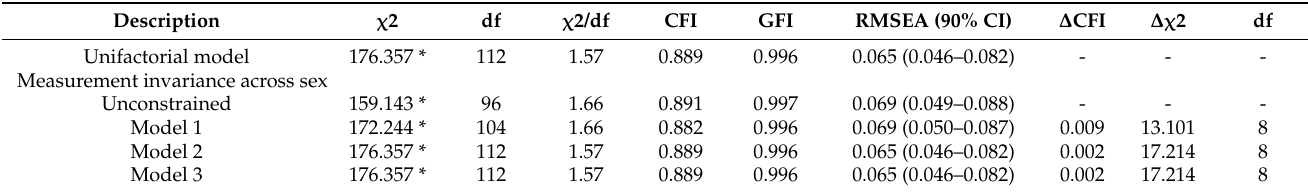
Table 5. Model fit indices in the unifactorial model and configurational invariance by